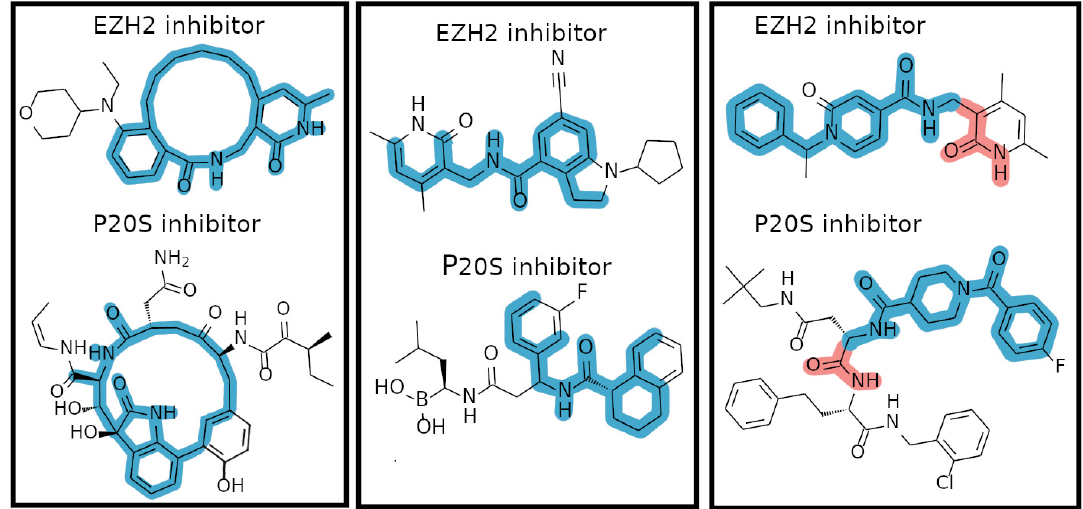
Figure 4. Representative examples of identified shared substructures between EZH2 and P20S inhibitors. Strictly mapped bonds/atoms are shown in blue (where aromatic only map to aromatic and aliphatic to aliphatic), and relaxed mappings (aromatic atoms can be matched to equivalent aliphatic atoms) are shown in red.